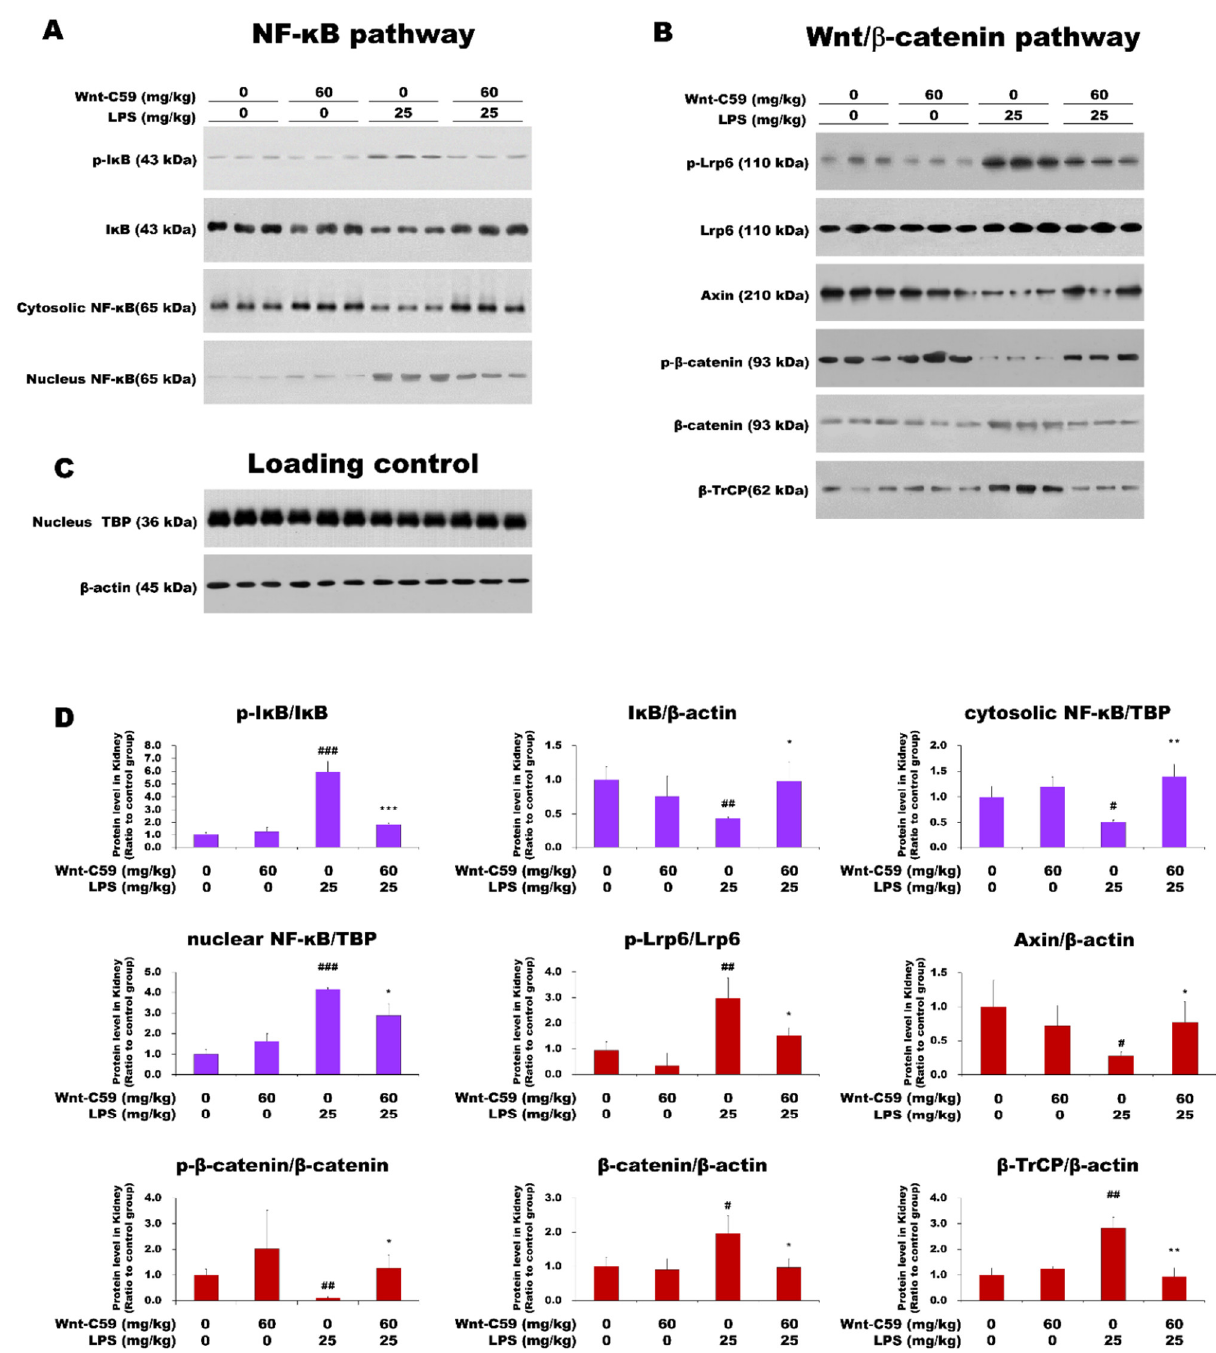
Figure 3. Wnt-C59 suppressed both the NF- κ B and Wnt/ β -catenin pathways in the kidney. C57BL/6 mice were i. p. injected with 0 or 60 mg/kg of Wnt-C59 and then with 0 or 25 mg/kg of lipopolysaccharide (LPS) after 2 h. ( A ) To measure the levels of the proteins involved in the NF- κ B pathway, Western blotting was conducted using kidney protein extract from the endotoxemic mice ( n = 3). ( B ) The levels of the proteins involved in the Wnt/ β -catenin pathway were evaluated via Western blotting using kidney protein extract ( n = 3). ( C ) β -Actin and TBP were used as loading controls for total and nuclear lysates, respectively. ( D ) The Western-blot band intensities of the members of the NF- κ B and Wnt/ β -catenin pathways are shown in violet and red, respectively. The target band intensities were quantified using ImageJ (NIH, Bethesda, MD, USA) and were normalized to the band intensities of the loading controls. The data show the average ± standard deviation ( n = 3). * p < 0.05, ** p < 0.01, and *** p < 0.001 compared with the group injected with 25 mg/kg of LPS. # p < 0.05, ## p < 0.01, and ### p < 0.001 compared with the control group (unpaired t -test). TBP: TATA-box–binding protein.